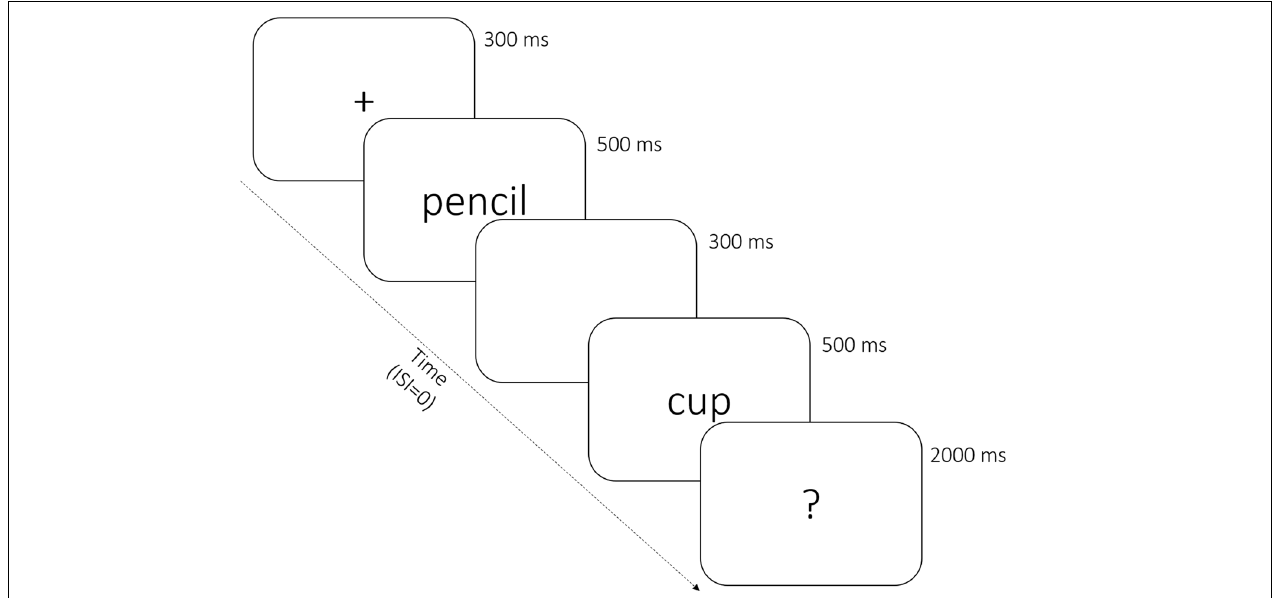
FIGURE 1 | Experimental sequence.